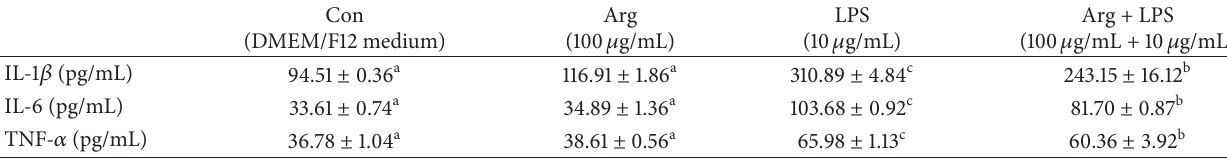
Table 2: Effects of Arginine on protein expression of cytokines in LPS-treated BMECs.